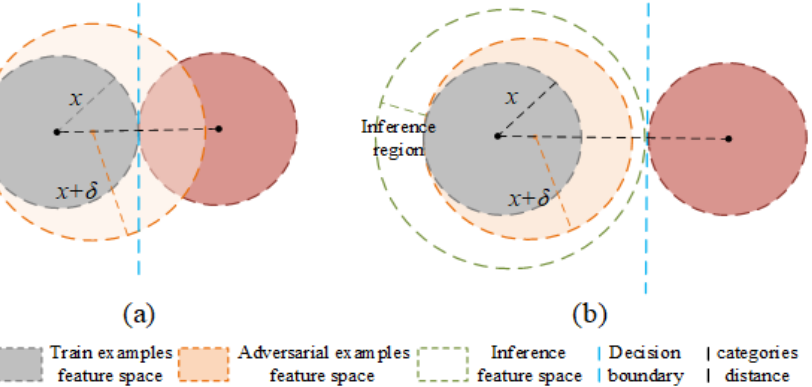
Figure 1. Illustration of the inference region. ( a ) is the decision boundary of SCE; ( b ) is the decision boundary using the inference